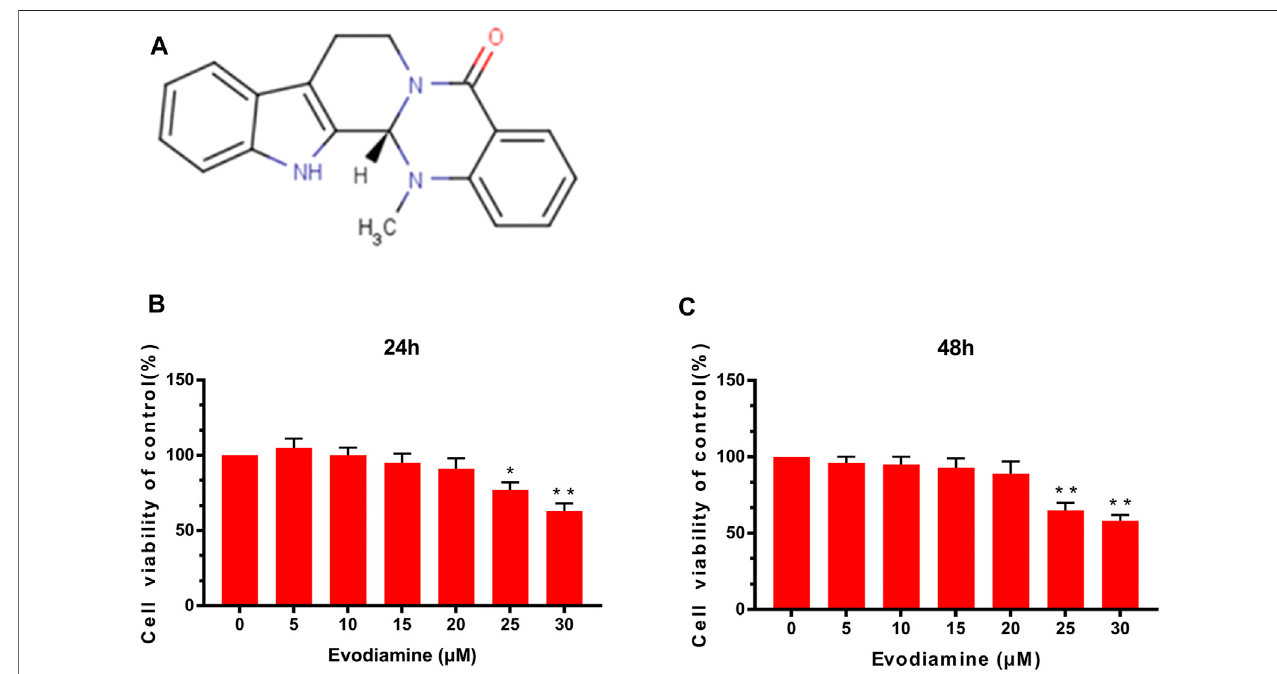
FIGURE 1 | Effects of evodiamine on chondrocyte cytotoxicity. (A) Chemical formula of evodiamine. (B,C) Effect of EV on chondrocyte viability at different concentrations. Data were expressed as mean ± SD. p p < 0.05, pp p < 0.01 (vs. con group, n = 3).